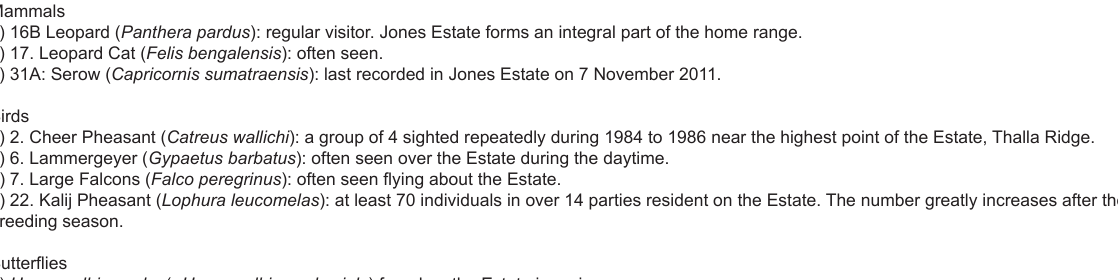
Table 2. Annotated list of wildlife included in the Indian Wildlife (Protection) Act 1972 and subsequent notifications recorded in Jones Estate since